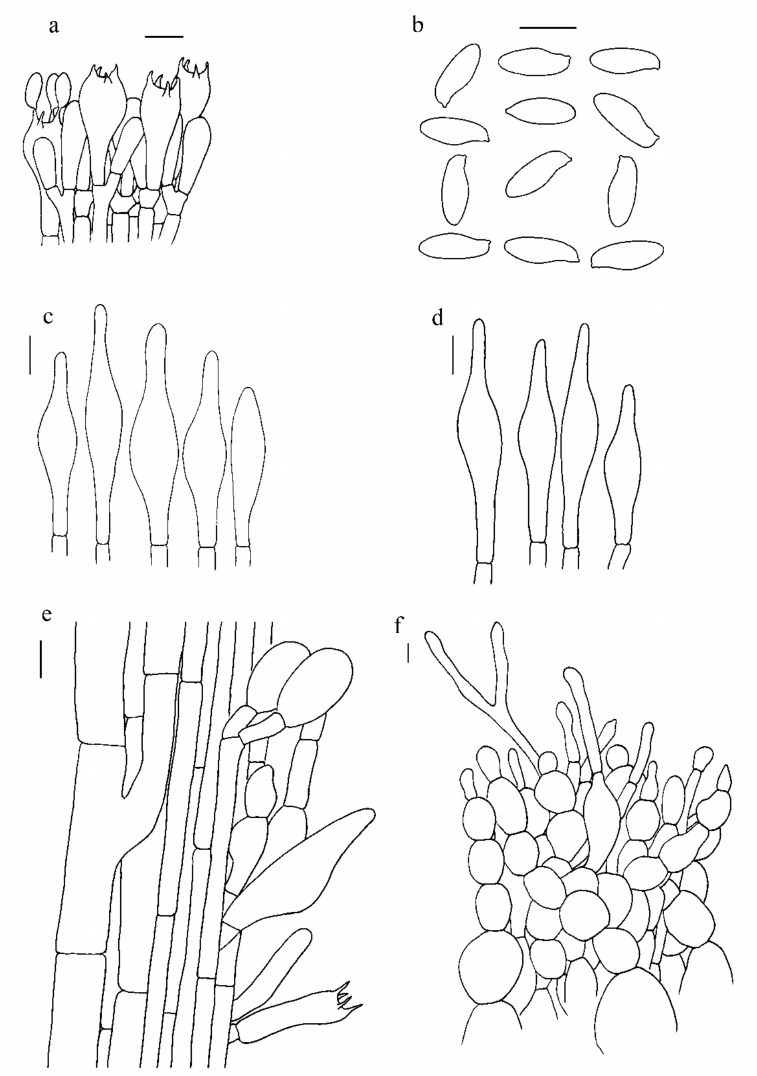
Figure 7. Microscopic features of H. ferrugineipes (Type, KUN-HKAS115554). ( a ). Hymenium and subhymenium; ( b ). Basidiospores; ( c ). Pleurocystidia; ( d ). Cheilocystidia; ( e ). Stipitipellis; ( f ). Pileipellis. Bars : a = 20 µ m, b = 30 µ m, c–e = 20 µ m, f = 10 µ